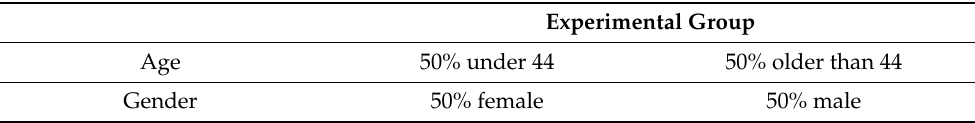
Table 1. Composition of the experimental groups.